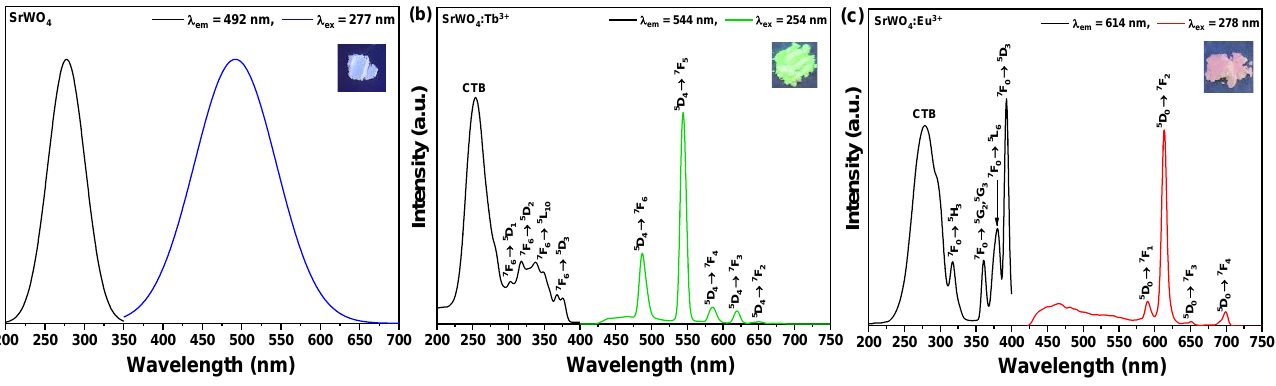
Figure 4. Photoluminescence spectra of ( a ) SrWO 4 , ( b ) SrWO 4 :Tb 3+ , and ( c ) SrWO 4 :Eu 3+ samples.